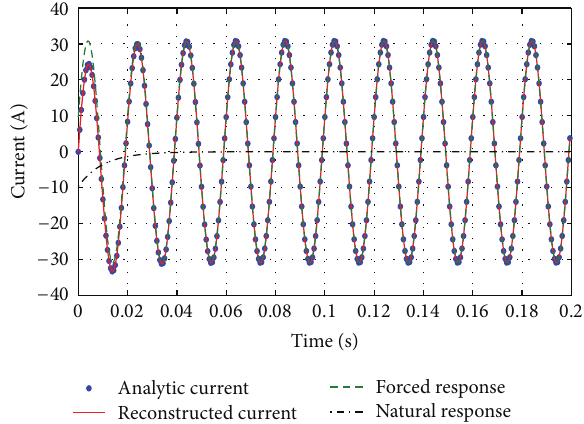
Figure 1: The analytic and reconstructed currents of the series RC circuit along with its forced and natural responses.